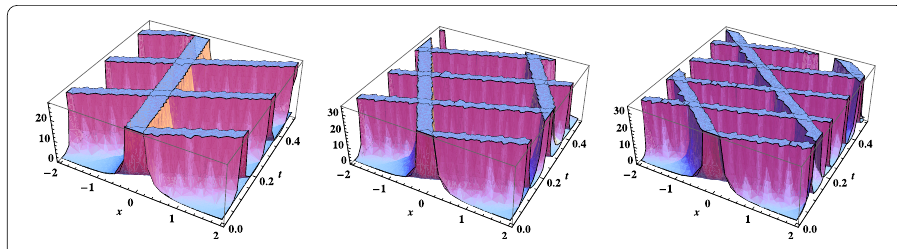
Figure 5 Shapes of the two-waves depicted in (3.6) by increasing the phase velocity: s = 1,5,10, respectively, and the other assigned values are A = μ = β =